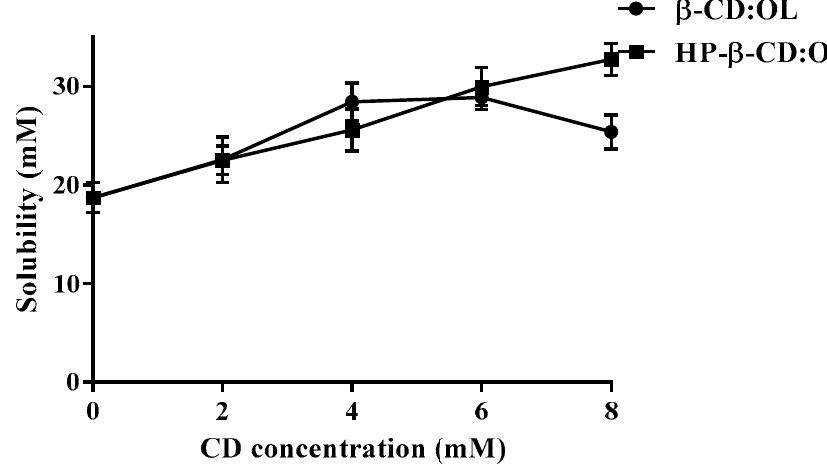
Figure 3. Phase solubility diagrams of OL with beta-CD and HP-beta-CD under 25 °C.